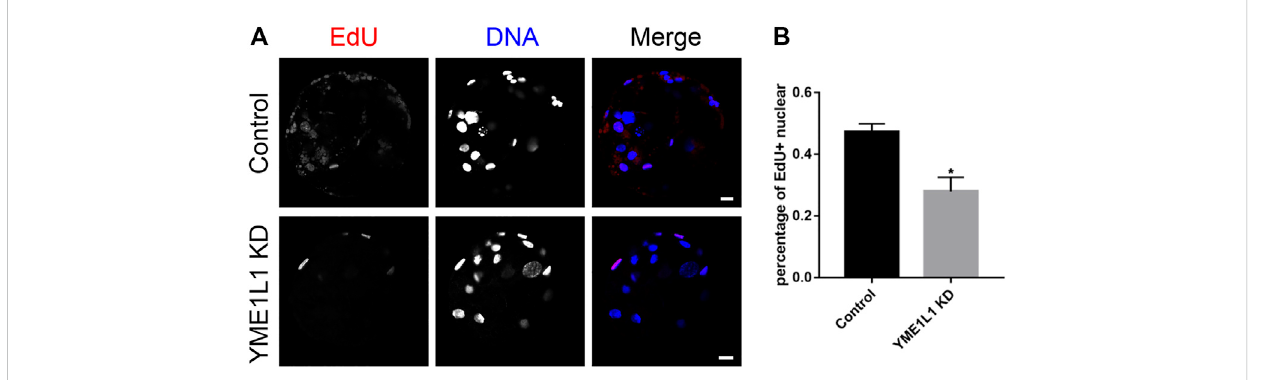
Knock-down of YME1L1 disrupts embryo development by inhibition of proliferation. (A) Representative images of Control and YME1L1 KD blastocysts showed EdU positive signals. Scale bars, 20 μ m. (B) The ratio of EdU positive nuclear to total nuclear number (proliferative ability index) in